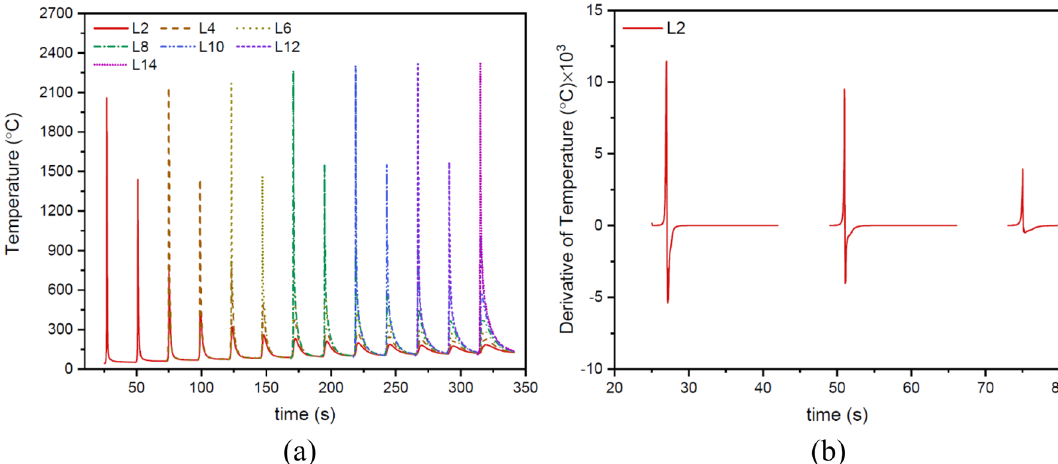
Figure 10. ( a ) Thermal cycles in the middle position of the lengths of layers 2, 4, 6, 8, 10, 12, and 14. ( b ) The first-order derivative of temperature with respect to time for the thermal cycle of layer 2 in ( a ).